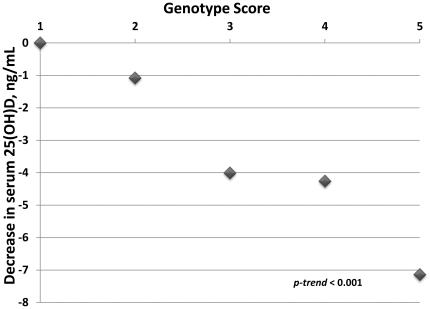
Genotype score in relation to serum 25(OH)D levels among African Americans.Plot of the estimated, average decrease in serum level of 25(OH)D (y-axis) in relation to genotype score (x-axis). Genotype score equals the sum of the number of risk alleles (i.e., A for rs2298849, G for rs2282679, and G for rs10877012). Estimates were derived from a linear regression model restricted to African Americans, using a genotype score of 1 as a referent, and including covariates for sex and level of African ancestry.